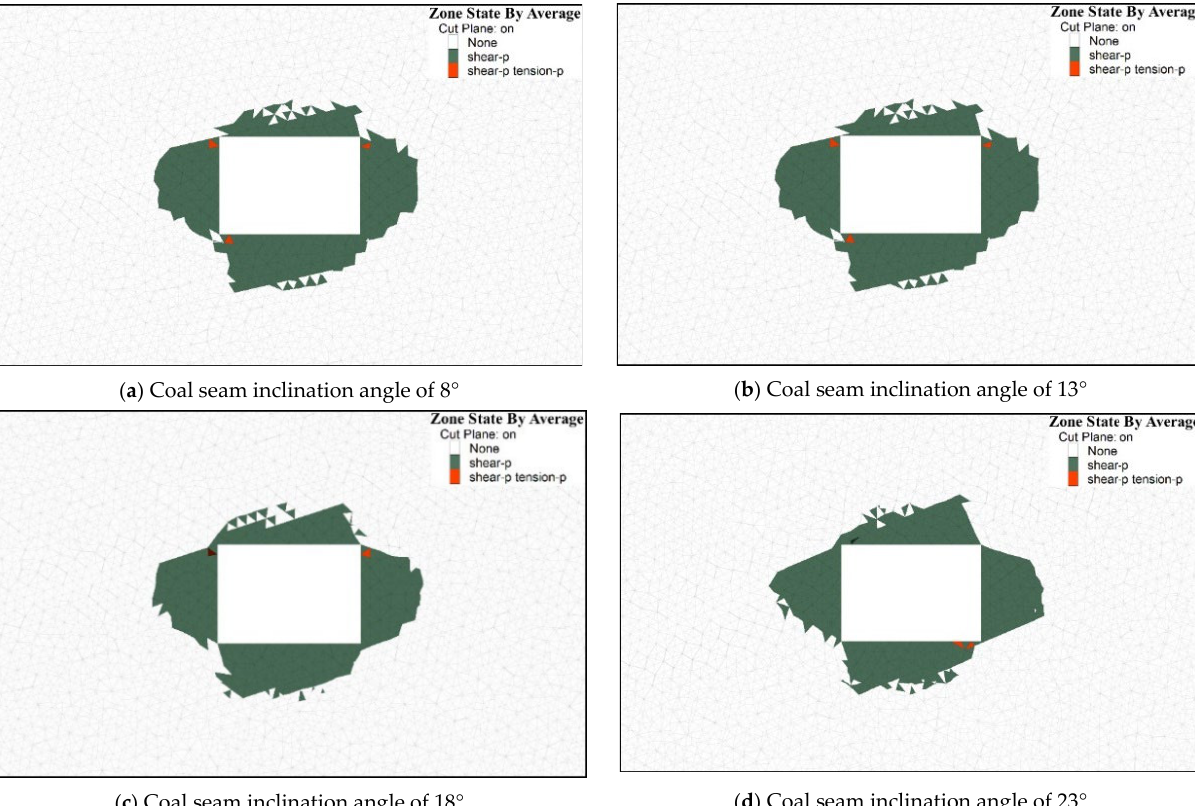
Figure 12. Development of excavated plastic area of the roadway with different inclination angles.